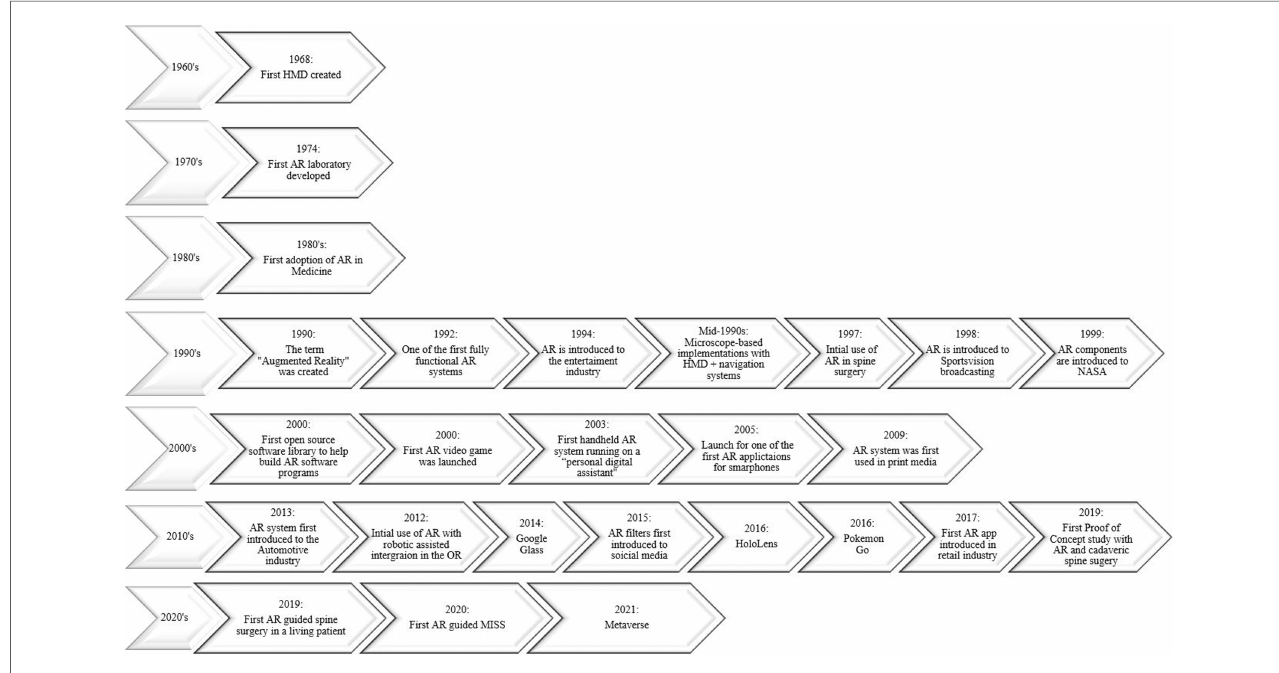
FIGURE 2 Timeline of AR technology (1960s – present). AR, augmented